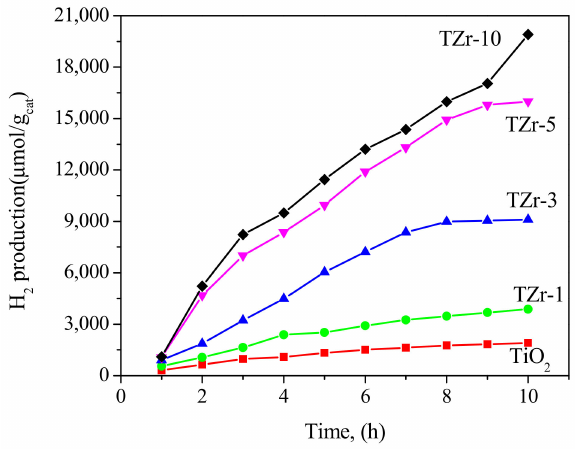
Figure 8. Hydrogen production profiles of the Ti–Zr